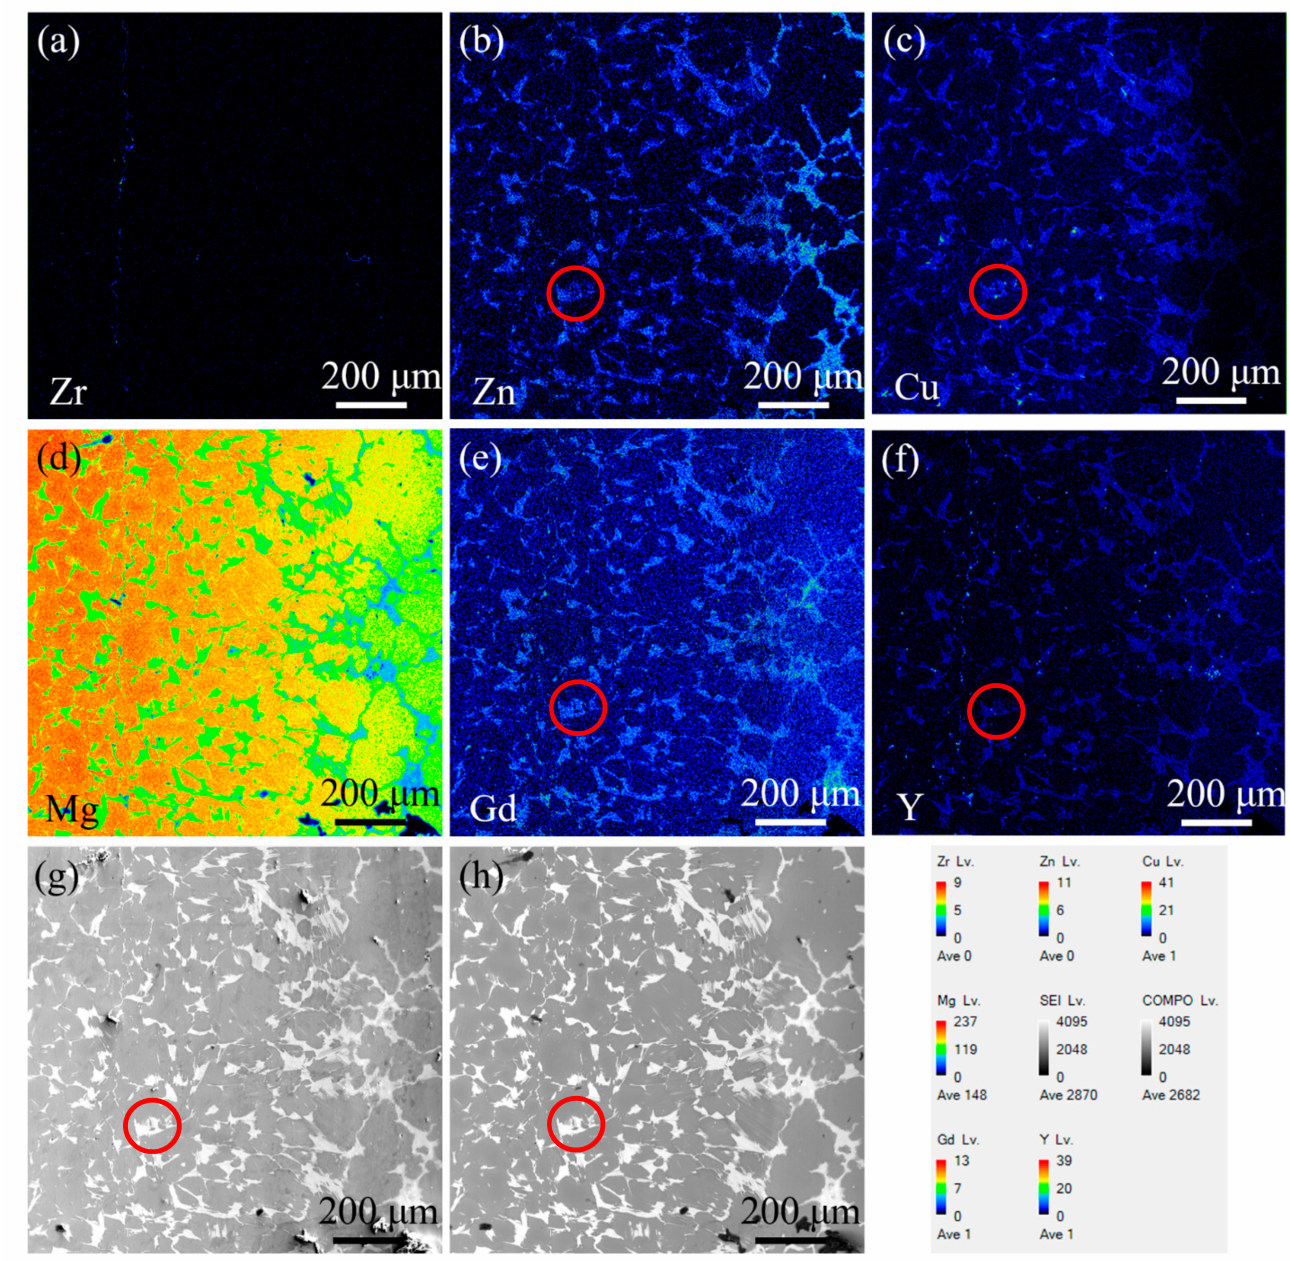
Figure 6. SEM-EDS element distribution maps of the joint bonding at 480 ◦ C, 1500# for 30 min under 2 MPa: ( a ) Zr; ( b ) Zn; ( c ) Cu; ( d ) Mg; ( e ) Gd; ( f ) Y; ( g ) and ( h ) SEM microstructure image of the